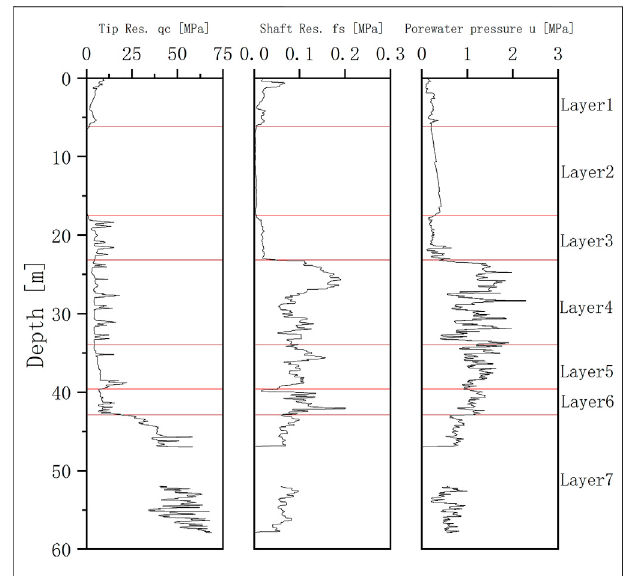
FIGURE 2 | The pro fi le of the cone penetration resistance, shaft resistance, and the pore water